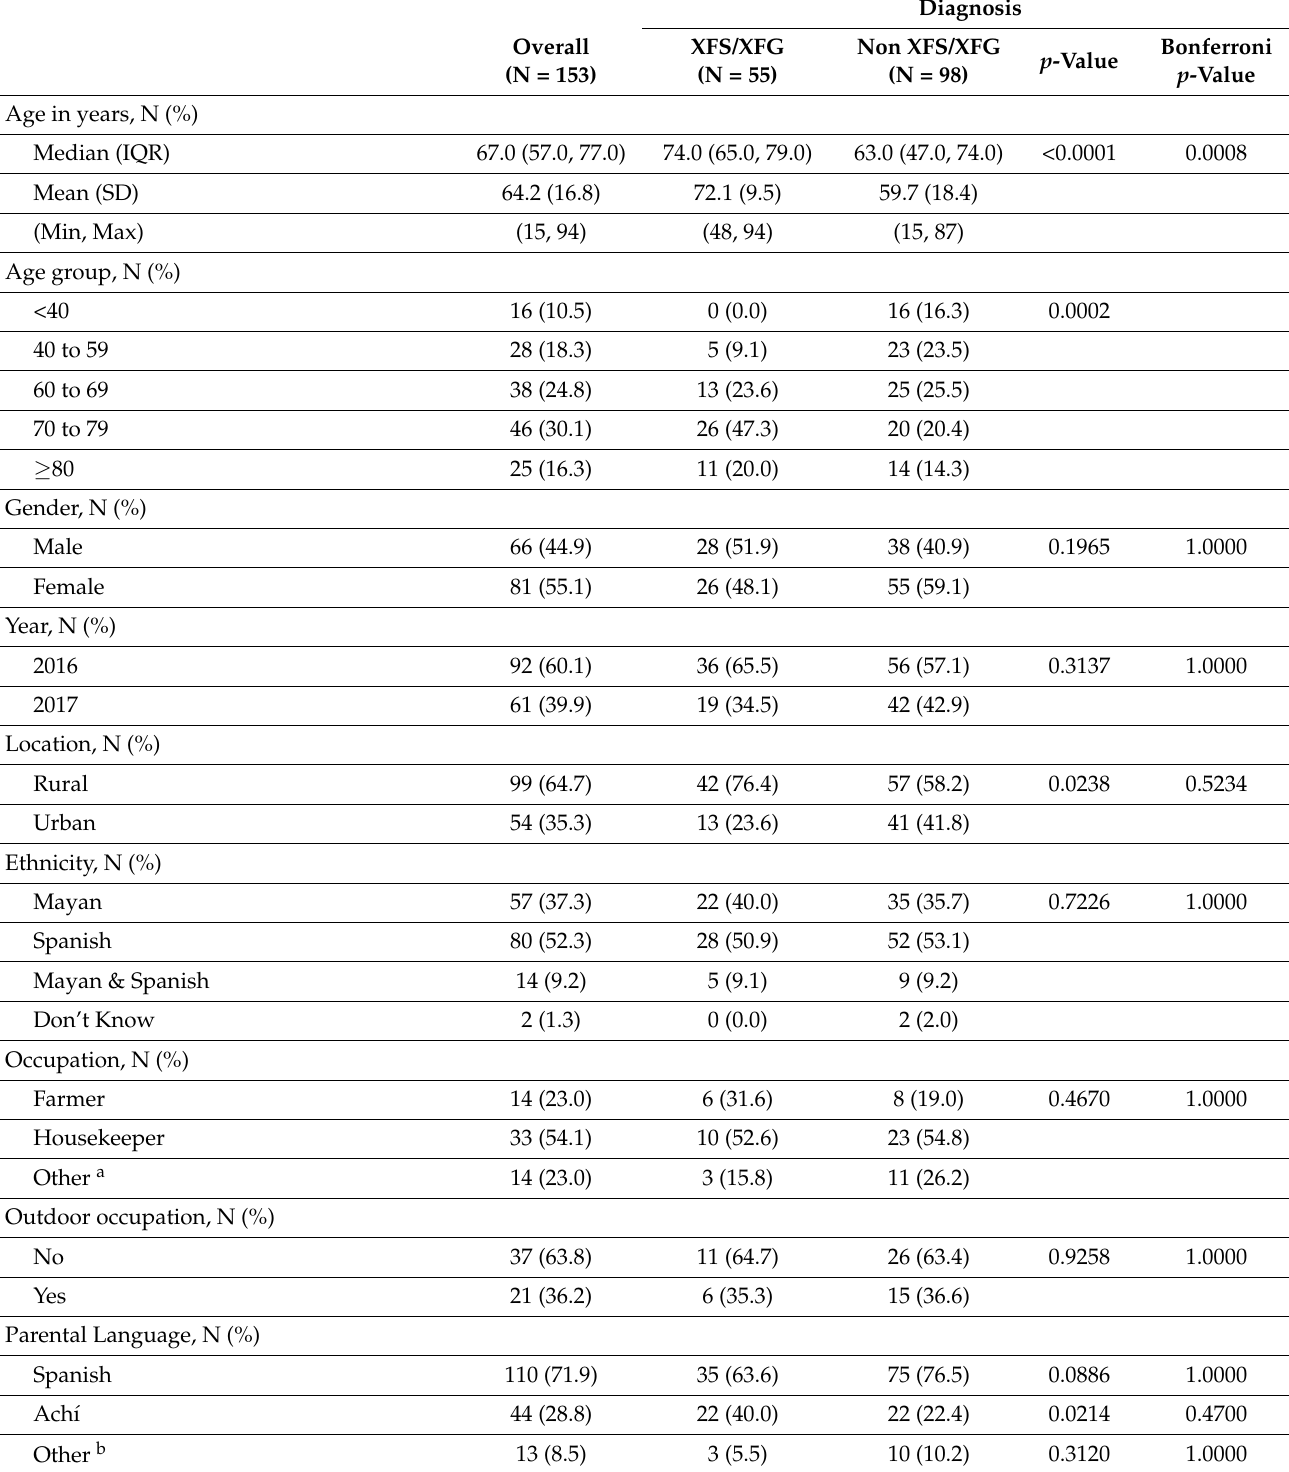
Table 1. Summary of demographics and comparison of XFS/XFG patients to non XFS/XFG